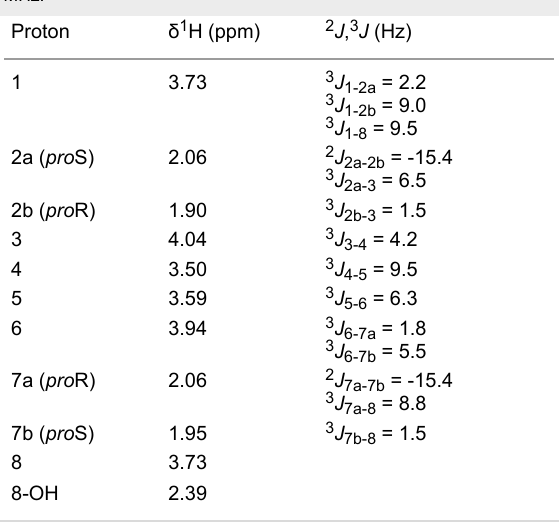
Table 1: Selected 1 H NMR data for compound 11 in CDCl 3 at 500 MHz.